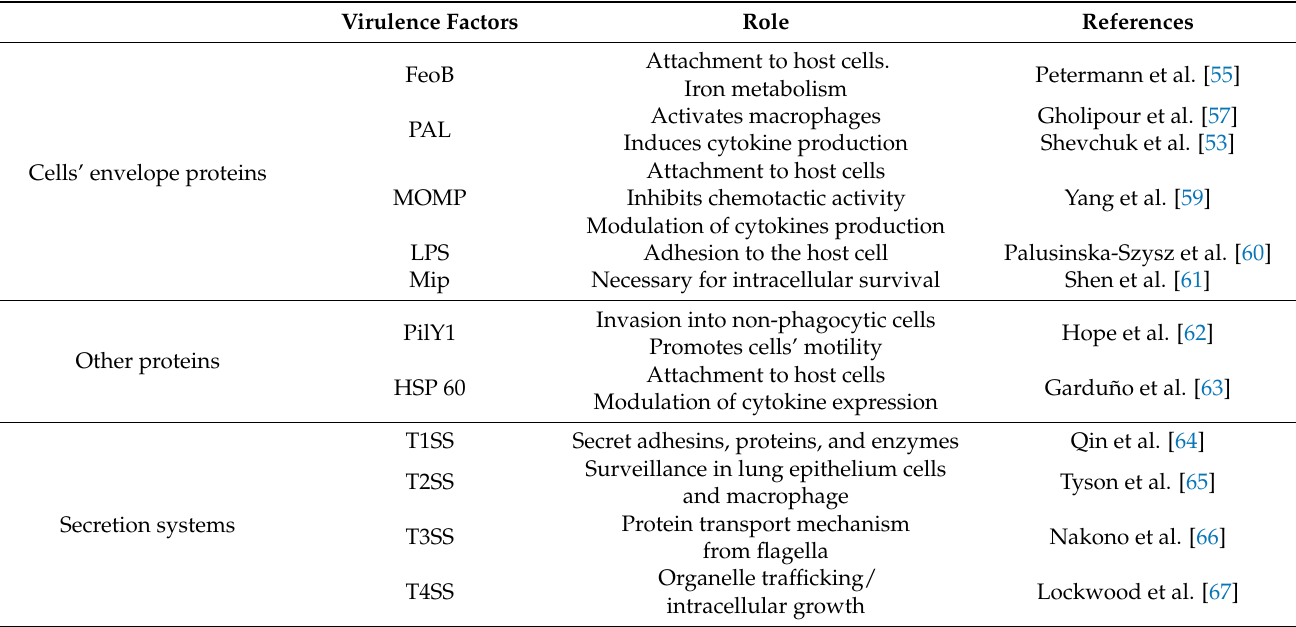
Table 1. Virulence factors of Legionella